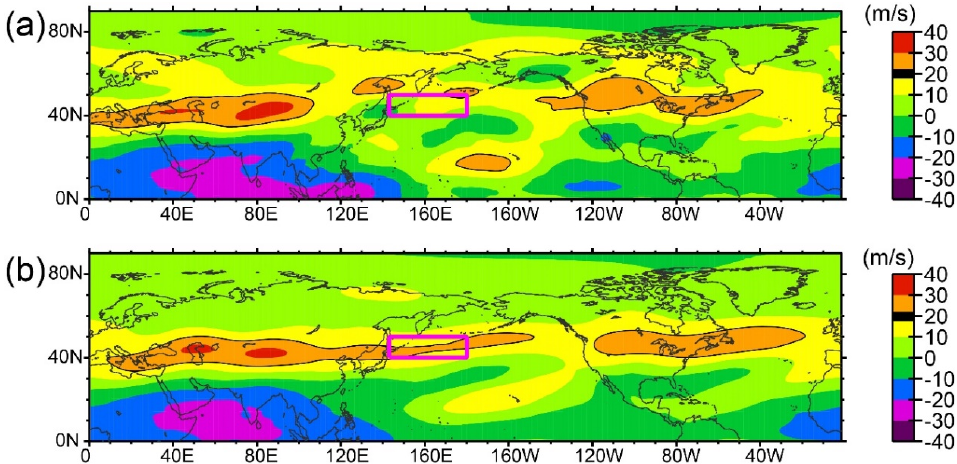
Figure 8. Eastward wind velocity at 200 hPa averaged over 10–30 July ( a ) in 2021 and ( b ) 1990–2019. The purple rectangle indicates the focal area (143°E–180°, 40°–50°N). Strong velocities of >20 m s − 1 are associated with the westerly jet.